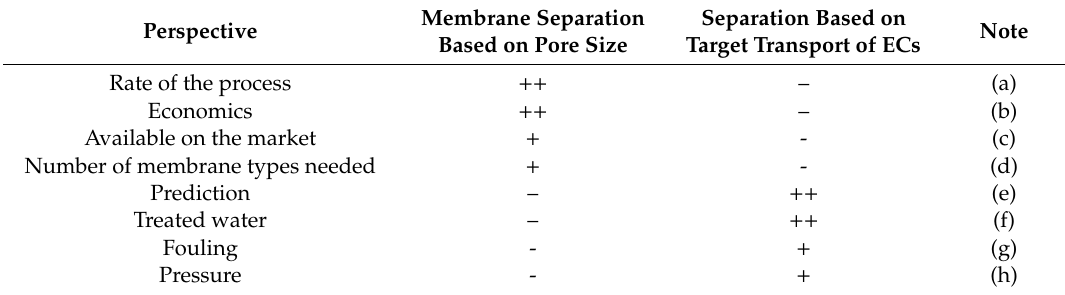
Table 4. Pluses and minuses of membrane separation based on pore size and on target transport of ECs through hydrophobic dense membranes. Membrane Separation Separation Based on Note Perspective Based on Pore Size Target Transport of ECs Rate of the process ++ – Economics ++ Available on the market + - Number of membrane types needed + - Prediction – Treated water Fouling - Pressure